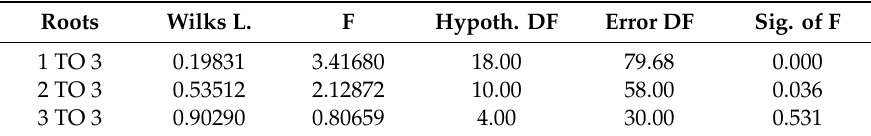
Table 6. Dimension reduction